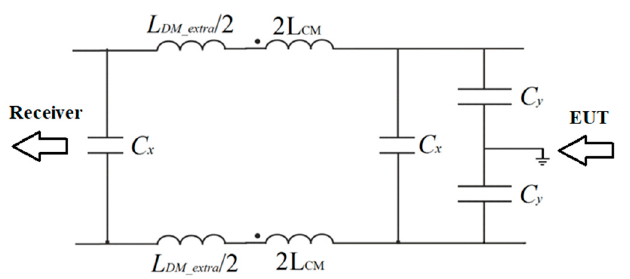
Figure 5. Γ - Π filter topology (single stage) for the experimental setup.